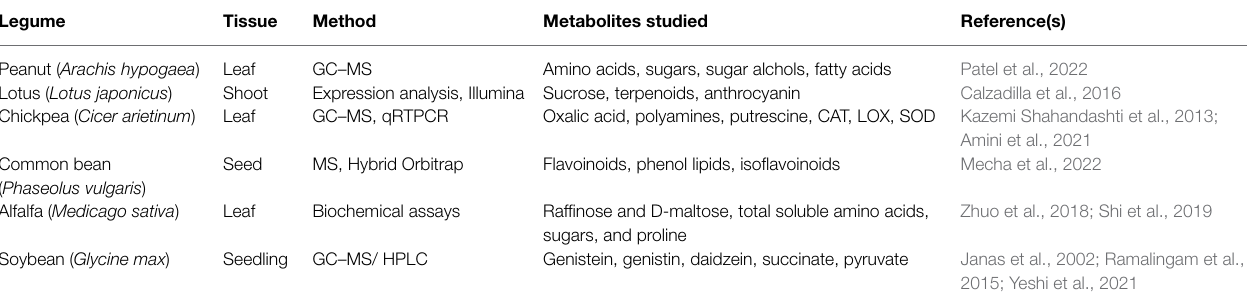
TABLE 5 | Overview of metabolic studies related to cold stress effects on some legumes.